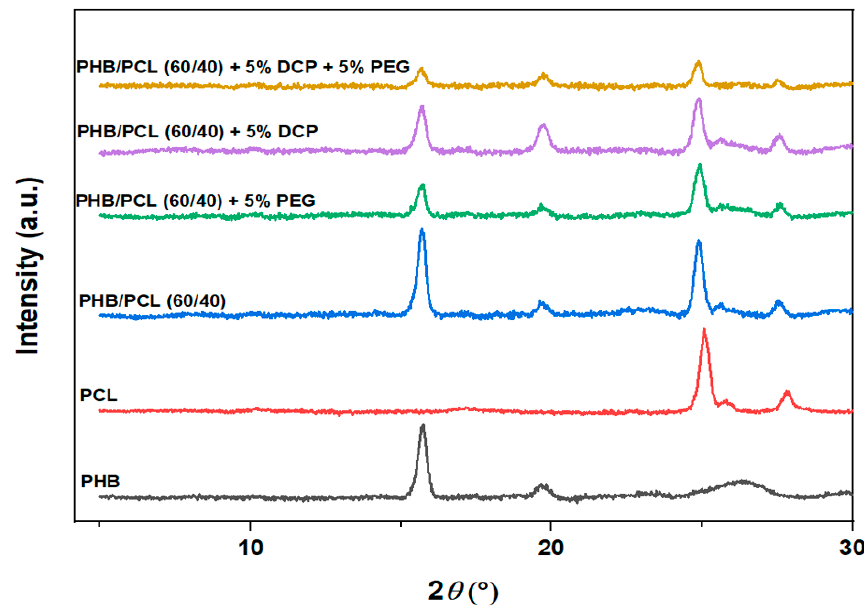
Figure 6. Diffractograms of PHB and PCL materials containing PEG and/or DCP.